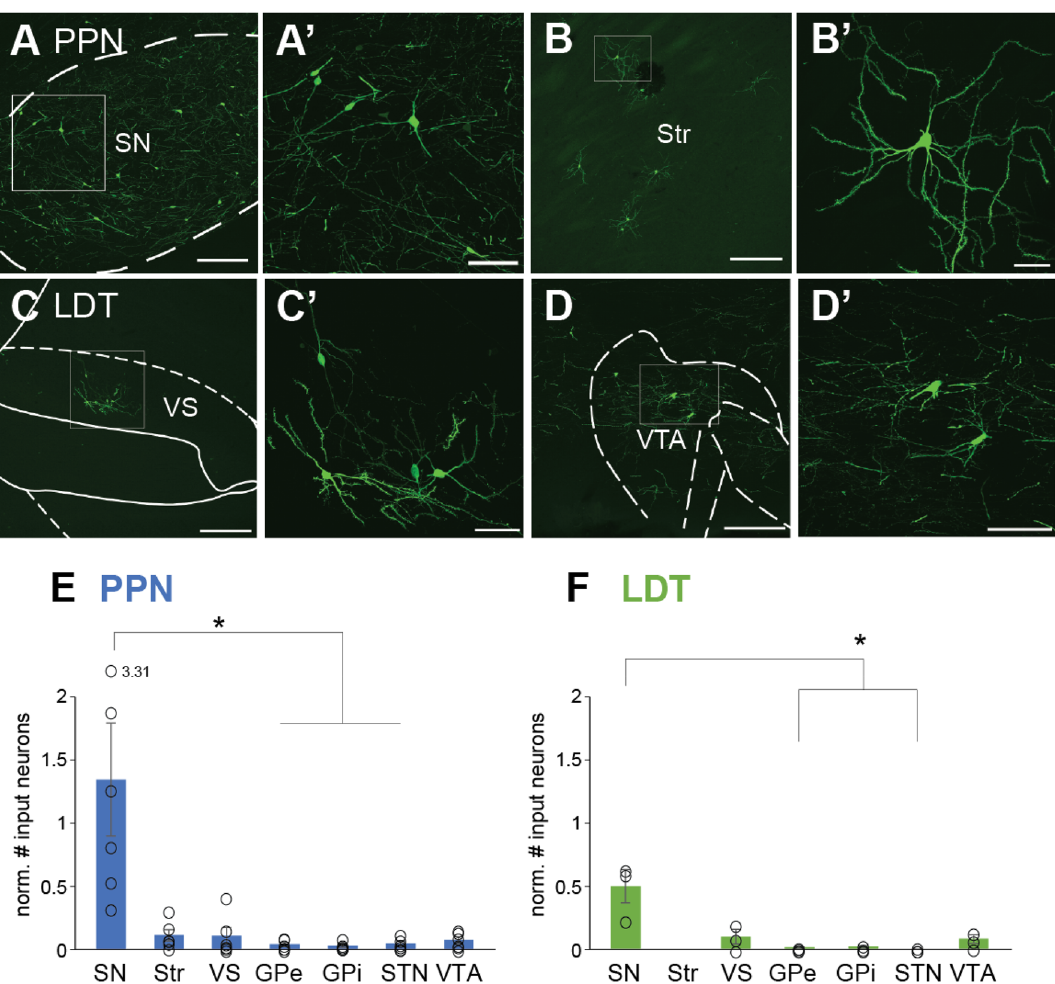
Figure 5. Basal ganglia input neurons predominantly target PPN. ( A–D ) Fluorescent micrographs in parasagittal sections showing basal ganglia input neurons that target the PPN ( A , B ) and LDT ( C , D ). Neurons located in the substantia nigra (SN) were predominantly observed after PPN injections ( A–A ′ ). Input neurons in the dorsal striatum were only observed following PPN injections ( B–B ′ ); note the presence of multiple spines in the dendritic arbor of the labeled neuron, suggesting that it is spiny projection neuron. In contrast, LDT injections produced labeling of input neurons in the ventral striatum (VS; C–C ′ ) and the ventral tegmental area (VTA; D–D ′ ). The normalized number of input neurons (to the number of starter neurons) reveal a differential distribution between the PPN ( E ) and LDT ( F ). For both cases, the majority of neurons localize in the SN. Mean ± SEM (PPN n = 6 rats; LDT n = 3 rats). Kruskal–Wallis H test and Bonferroni corrected post hoc tests were performed to determine statistically significant differences, see text for values. Scale bars: ( A ), ( B ), ( C ) and ( D ), 250 µm. ( A ′ ) and ( D ′ ) 100 µm, ( B ′ ) and ( C ′ ) 50